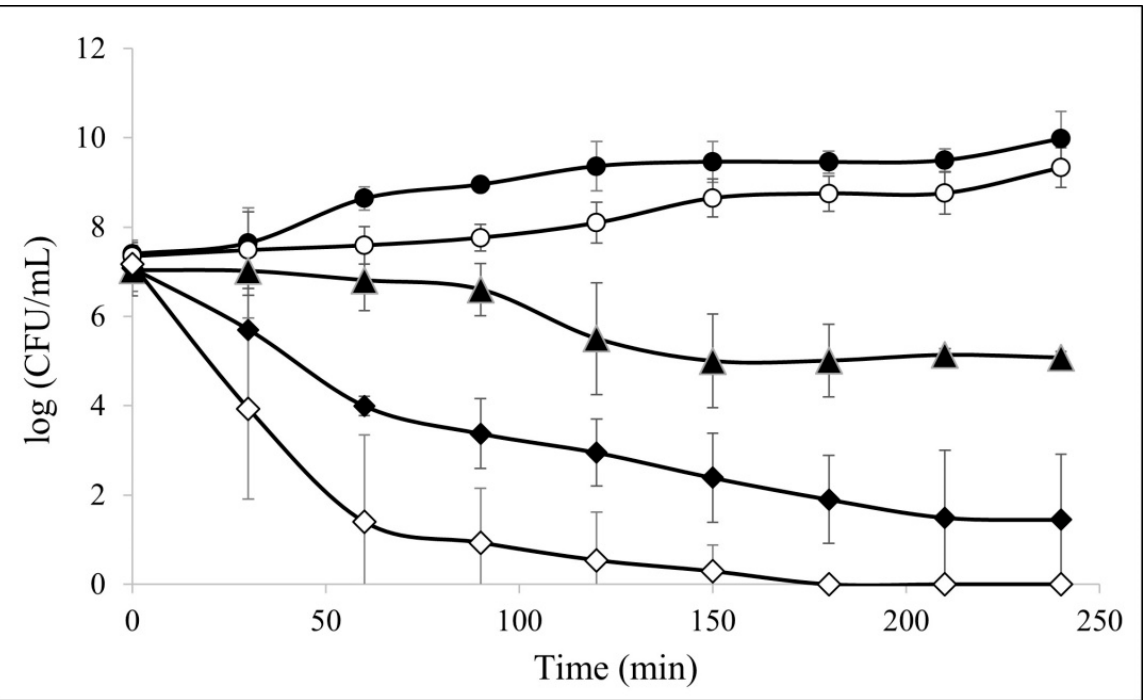
Figure 2. Time–kill curves of multidrug-resistant enterotoxigenic Escherichia coli (MDR ETEC) strain treated with different concentration of Q4-15a-1. (1× MIC = 4 μ g/mL) Untreated; 0.5× MIC; 1× MIC; 2× MIC; 4× MIC.